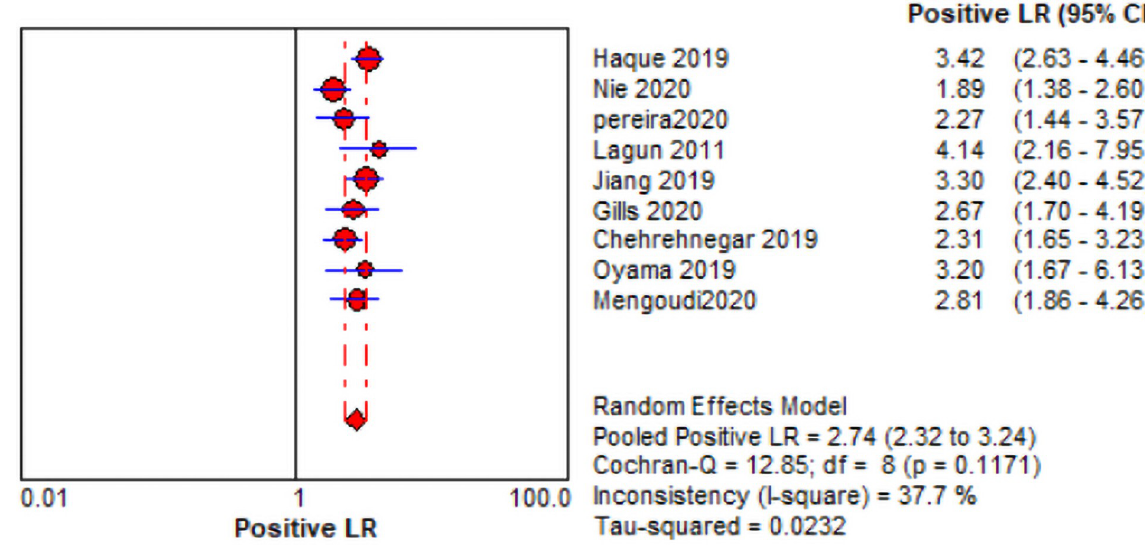
Fig 6. Forest map of LR+.